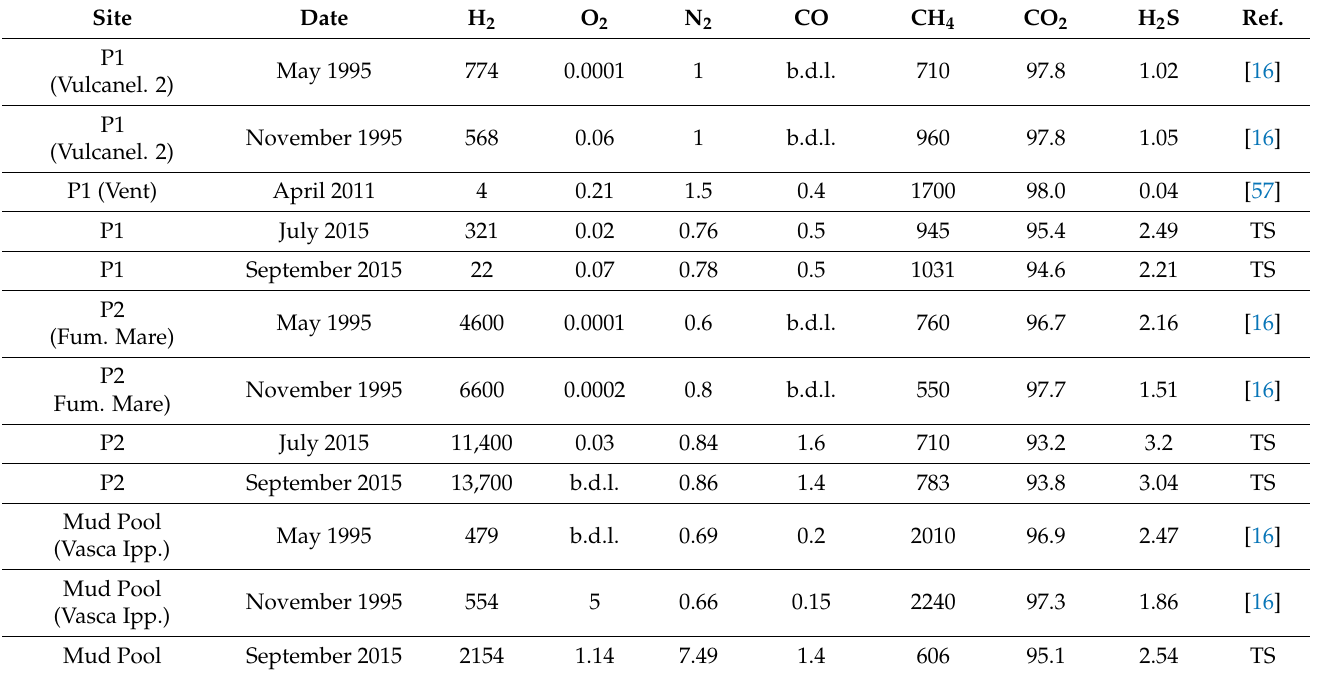
Table 1. Chemical composition of bubbling gases at Baia di Levante, from references and measured in this study (TS); the letters between brackets in the site field indicate the identifier of the point as in the original text. Values are in ppm for H 2 , O 2 , CO, and CH 4 , and in %vol for N 2 , CO 2 , and H 2 S. Site